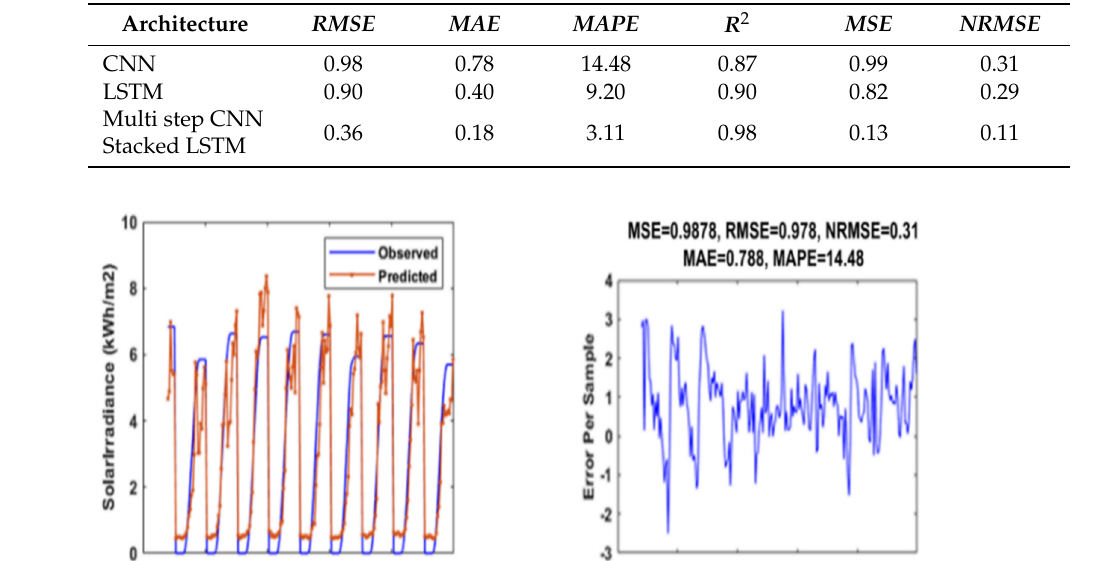
Table 4. Comparison of different DL architectures utilizing solar irradiance data.